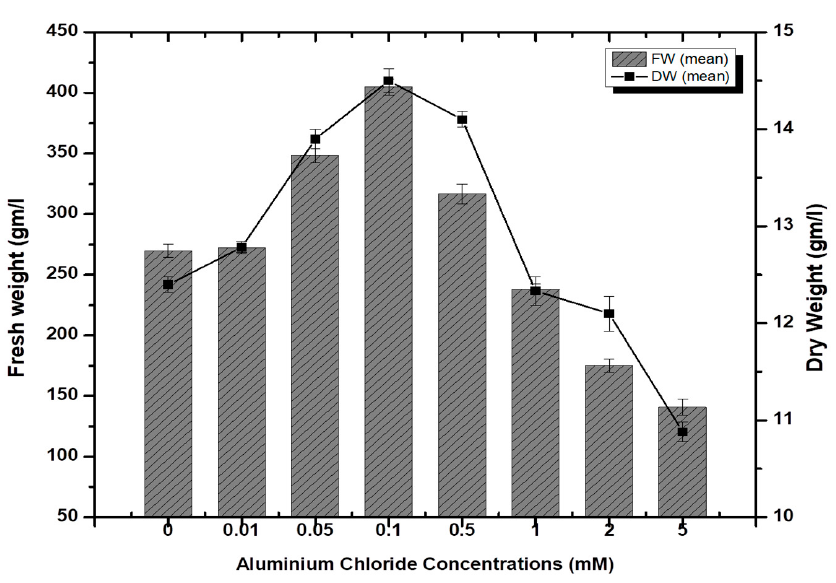
Figure 2. Aluminum chloride-elicited biomass accumulation (fresh and dry weight) in callus culture of F. indica under seven different concentrations along with control. All the values are mean ± SE.